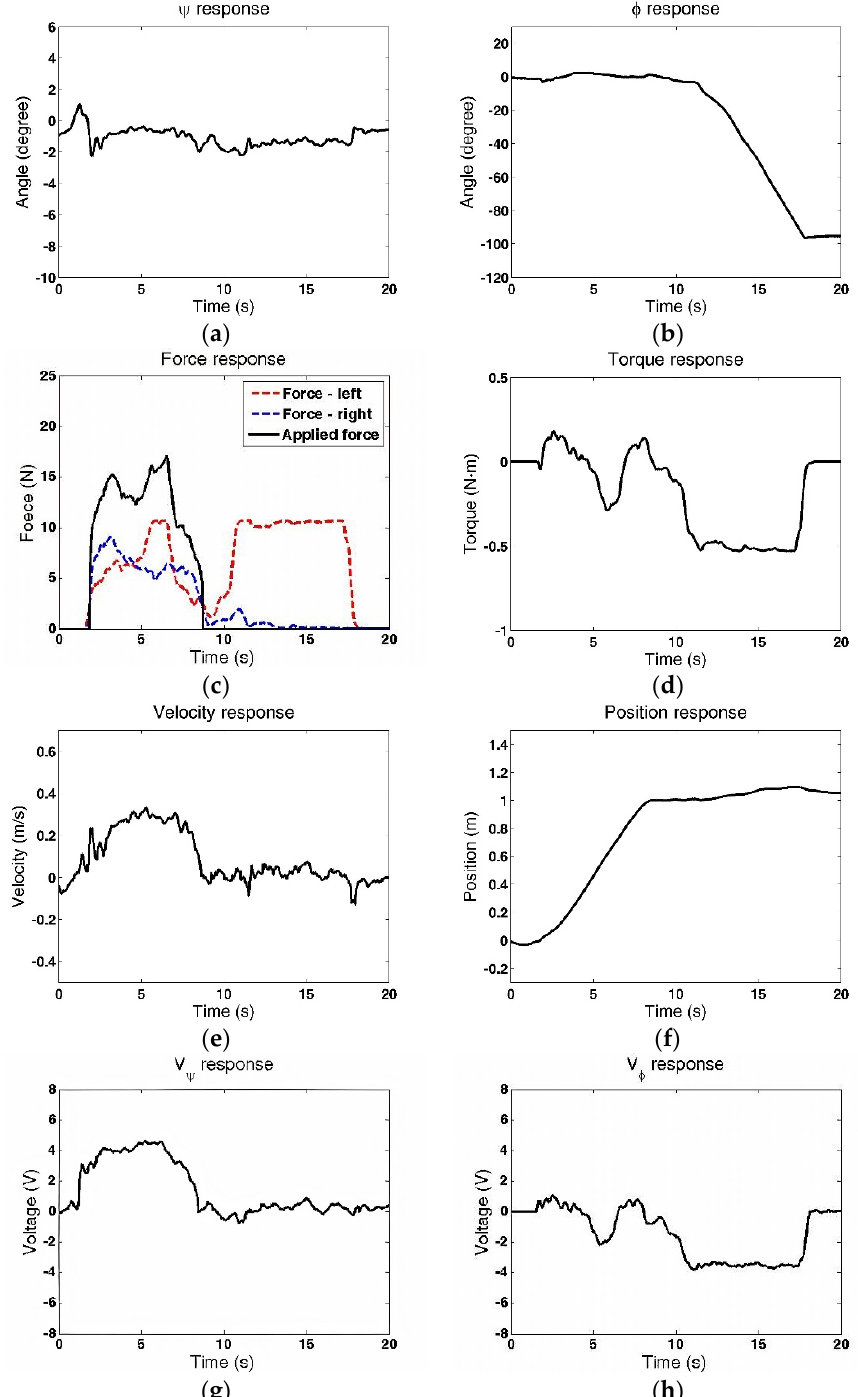
Figure 14. Experimental responses for walking assistance: ( a ) ψ response; ( b ) φ response; ( c ) Force response; ( d ) Torque response; ( e ) Velocity response; ( f ) Position response; ( g ) motor voltage V ψ ( t ) ; ( h ) motor voltage V φ ( t )